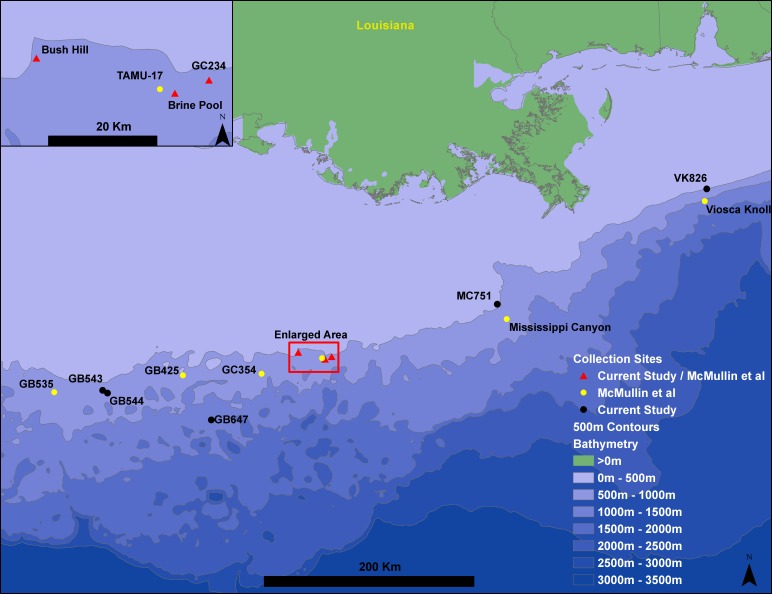
Gulf of Mexico seep locations from which Seepiophila jonesi individuals were collected.Seeps sites illustrated include those from the present study and McMullin et al. (2010). Sites are named for the Bureau of Ocean Energy Management Lease block in which they occur. The 500 m contours are from Geomapapp base + NOAA Coastal Relief Model—Gulf of Mexico (http://www.marine-geo.org/about/legal.php#credits, Divens, DL and Metzger, D).